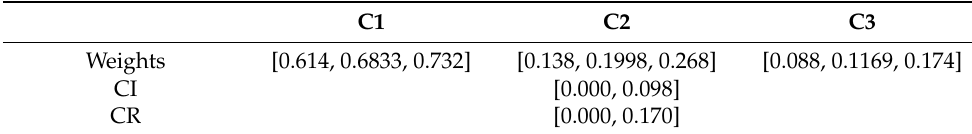
Table 2. The FAHP with the fuzzy weights and consistent